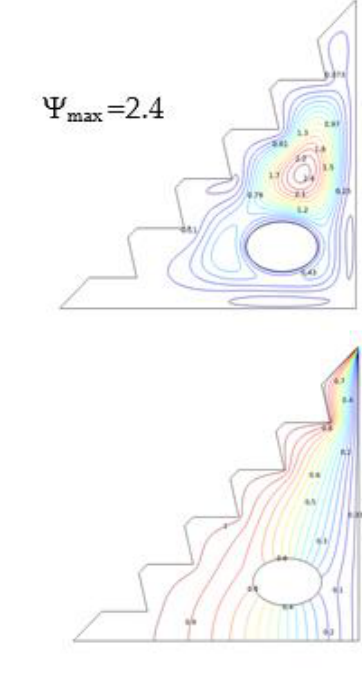
Figure 8. Streamlines and isotherms for Ha = 0, w = 0, and ϕ = 0.02.